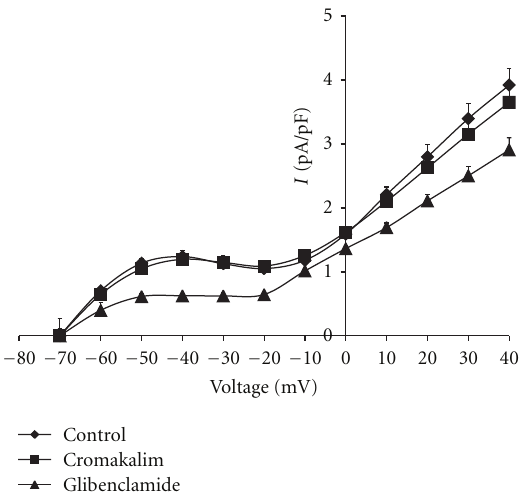
Figure 2: Voltage-Current Relationship in Volume-Overloaded Shunted Rats. Sarcolemmal outward potassium current (I), expres- sed as current density (pA/pF), in patches of ventricular myocytes from adult experimental rats subjected to a surgical operation to produce shunting of blood from the aorta to the van cava. The membrane voltage was clamped at steps of 20mV from − 80mV to +40mV. Di ff erences in pA/pF in the presence and absence of treatment with cromokalimand post-treatment with glibenclamide were not significant at the voltages from − 20 mV to +40mV ( P < 0 .